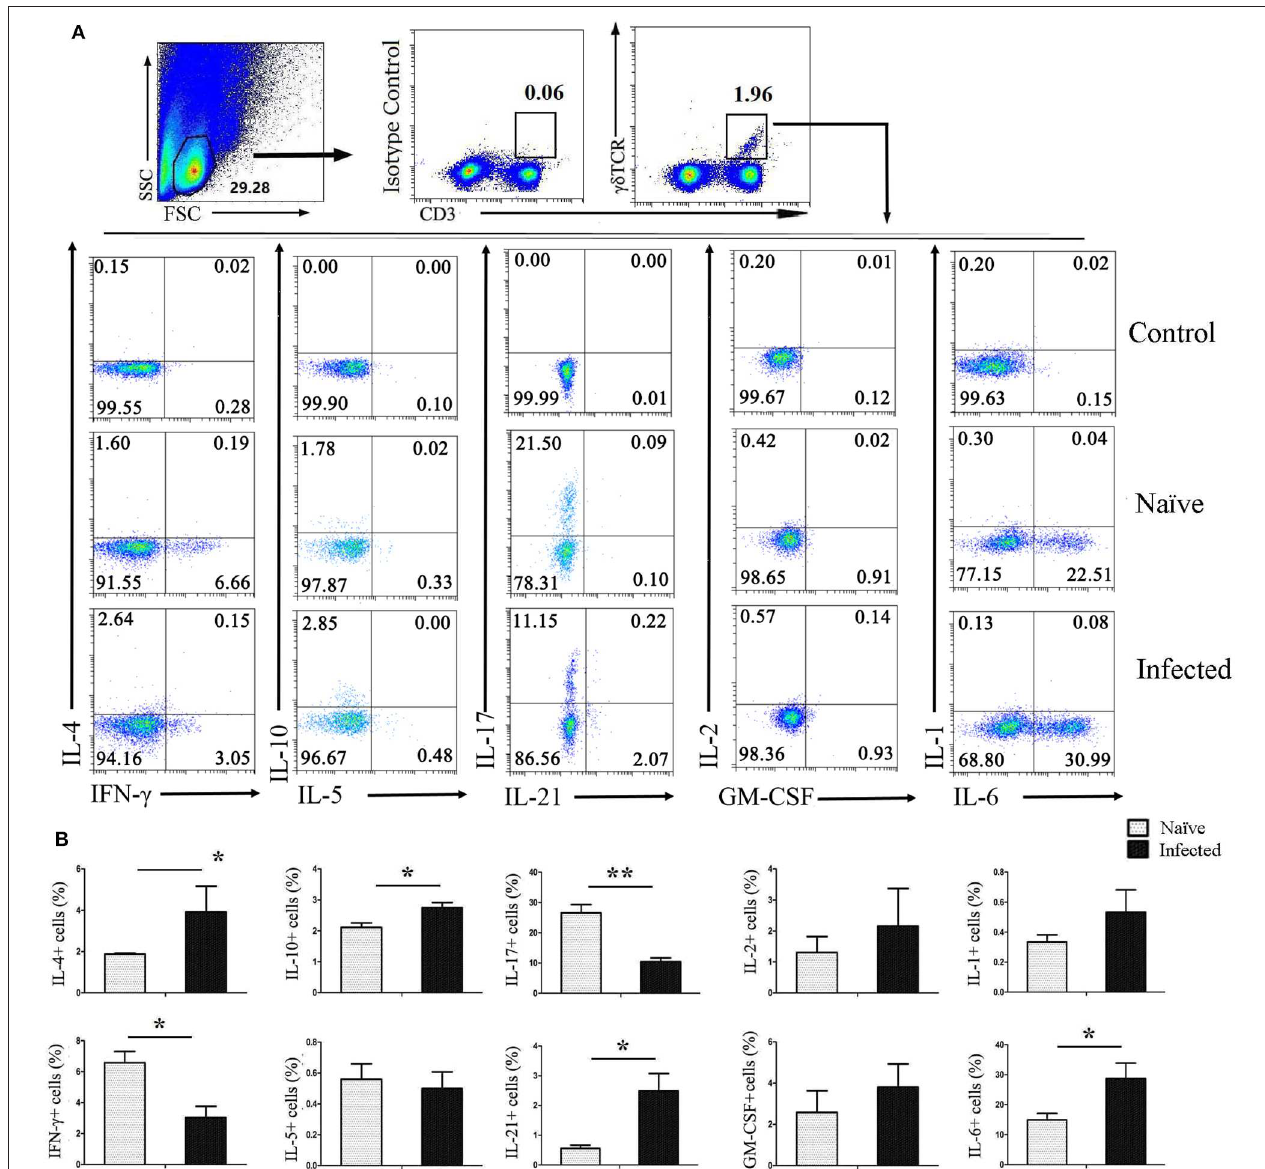
FIGURE 3 | Cytokines released by pulmonary γδ T cells. C57BL/6 mice were infected with 40 ± 5 S. japonicum cercariae per mouse, and 5–6 weeks after the infection, mice were euthanized. Single cell suspensions of lung cells were stimulated with PMA and ionomycin. Cytokine (IL-4, IFN- γ , IL-10, IL-5, IL-17, IL-21, IL-2, GM-CSF, IL-1, and IL-6) expression was detected in CD3 + γδ TCR + cells by FACS analysis. (A) A representative of four independent experiments with 5–6 mice per group is shown. (B) Average expression of different cytokines on CD3 + γδ TCR + cells was calculated by FACS data. The error bars are SD, ** P < 0.01, * P <